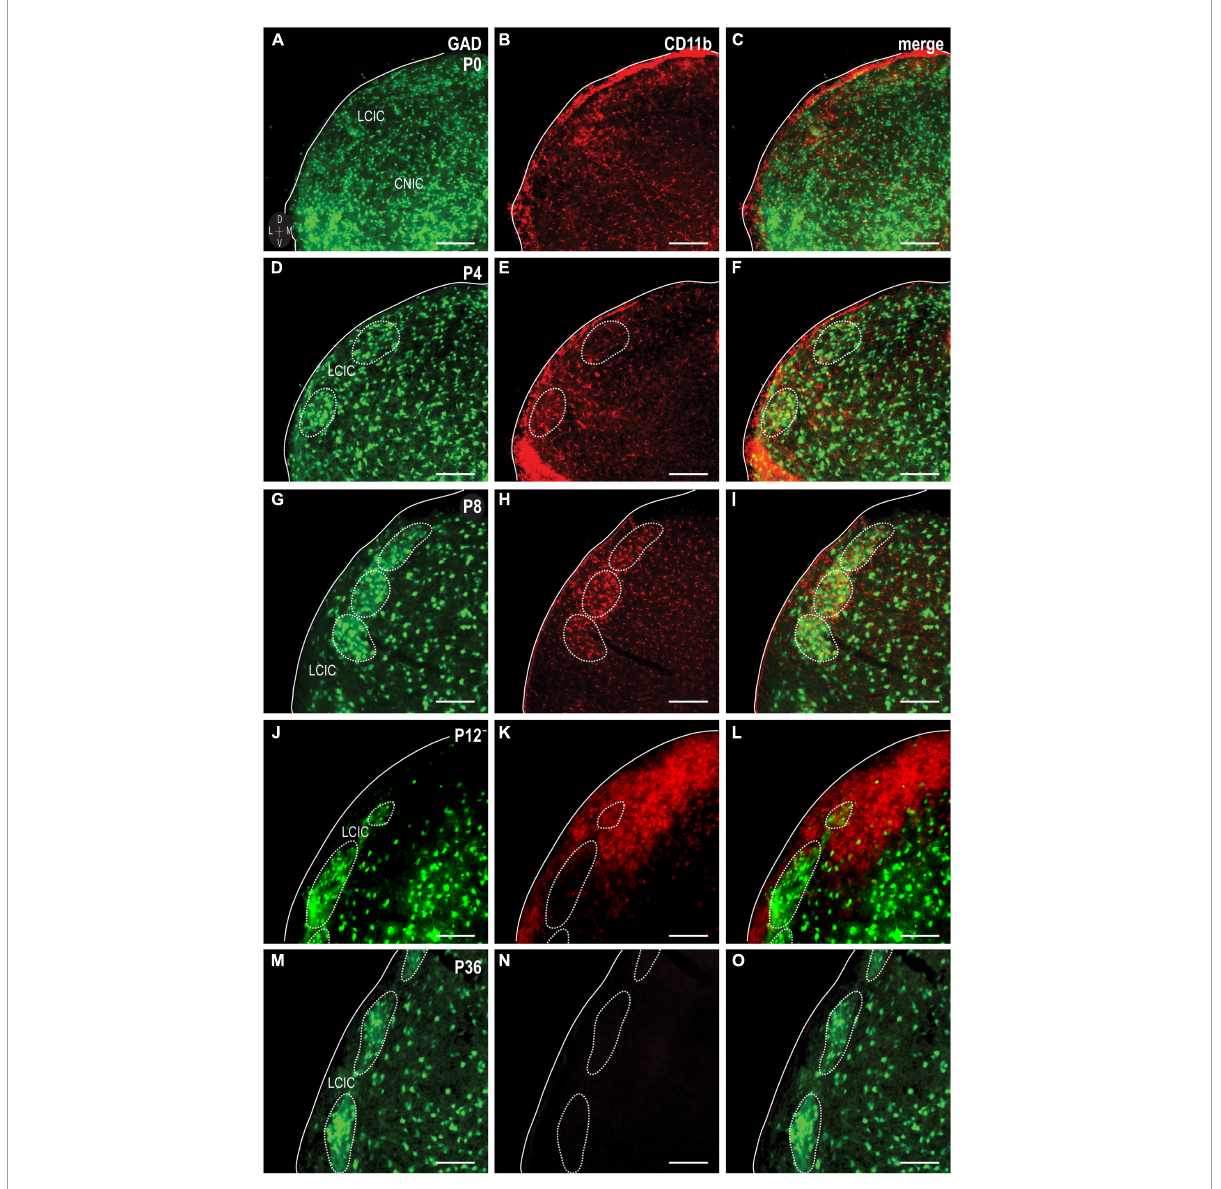
FIGURE3 Integrin α M (CD11b) expression (red) in a developmental series [P0, (A–C) ; P4, (D–F) ; P8, (G–I) ; P12, (J–L) ; P36, (M–O) ] of glutamic acid decarboxylase (GAD)-GFP (green) mice. CD11b expression is apparent and homogeneously distributed throughout IC subdivisions at birth, prior to concentrating more toward the lateral cortex of the inferior colliculus (LCIC) by P4. At P8, CD11b expression localizes most notably within LCIC GAD-defined modular fields. CD11b-expressing microglial cells (MGCs) shift to occupying the surrounding matrix at P12. By P36, CD11b expression is largely undetectable in the LCIC. Scale bars = 100 µ